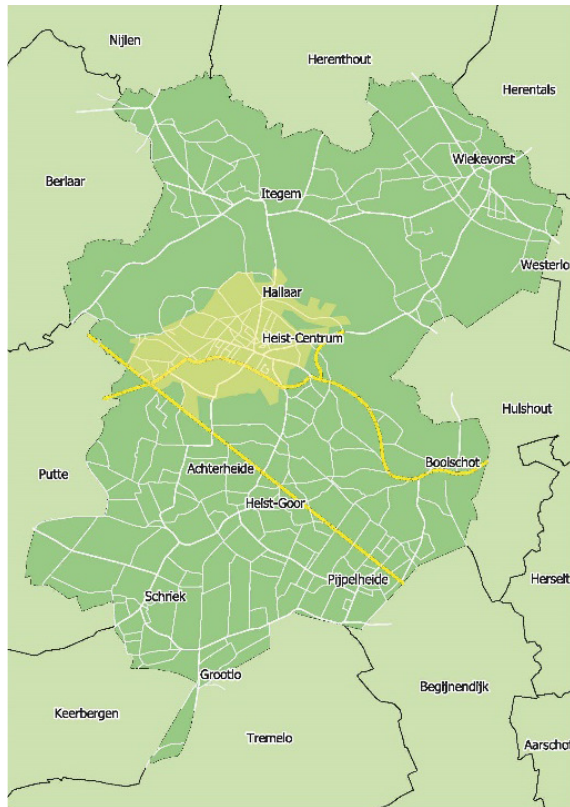
Figure 1. Merger municipality Heist‐op‐den‐Berg (dark green) with its core municipality Heist‐Centrum (yel‐ low) and sub‐municipalities and church villages, includ‐ ing Heist‐Goor. Image developed by the Municipality of